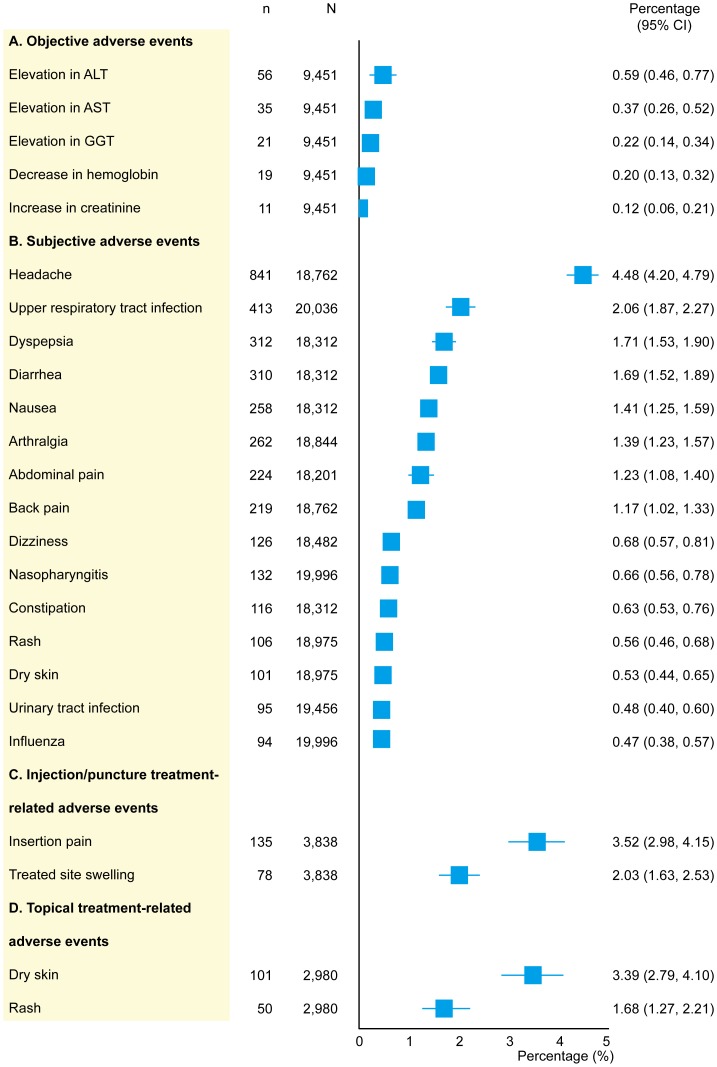
Rates of nonspecific adverse events.n, number of patients reporting adverse events; N, total sample size; ALT, alanine aminotransferase; AST, aspartate aminotransferase; GGT, gamma-glutamyltransferase.